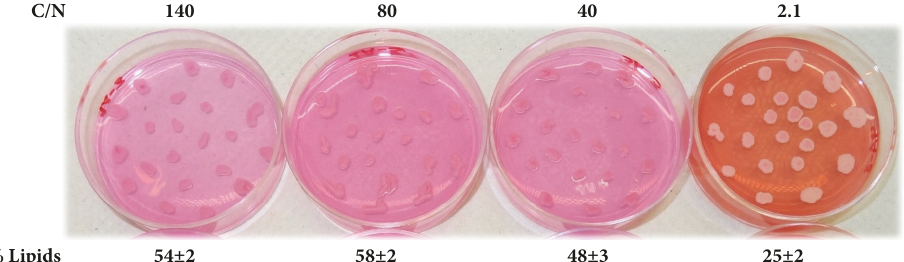
Figure 3: Y. lipolytica was cultured media with different C/N values (140, 80, 40, and 2.1) with 10 mg/L Rhodamine B for two incubation days. The lipid content was measured in triplicate.